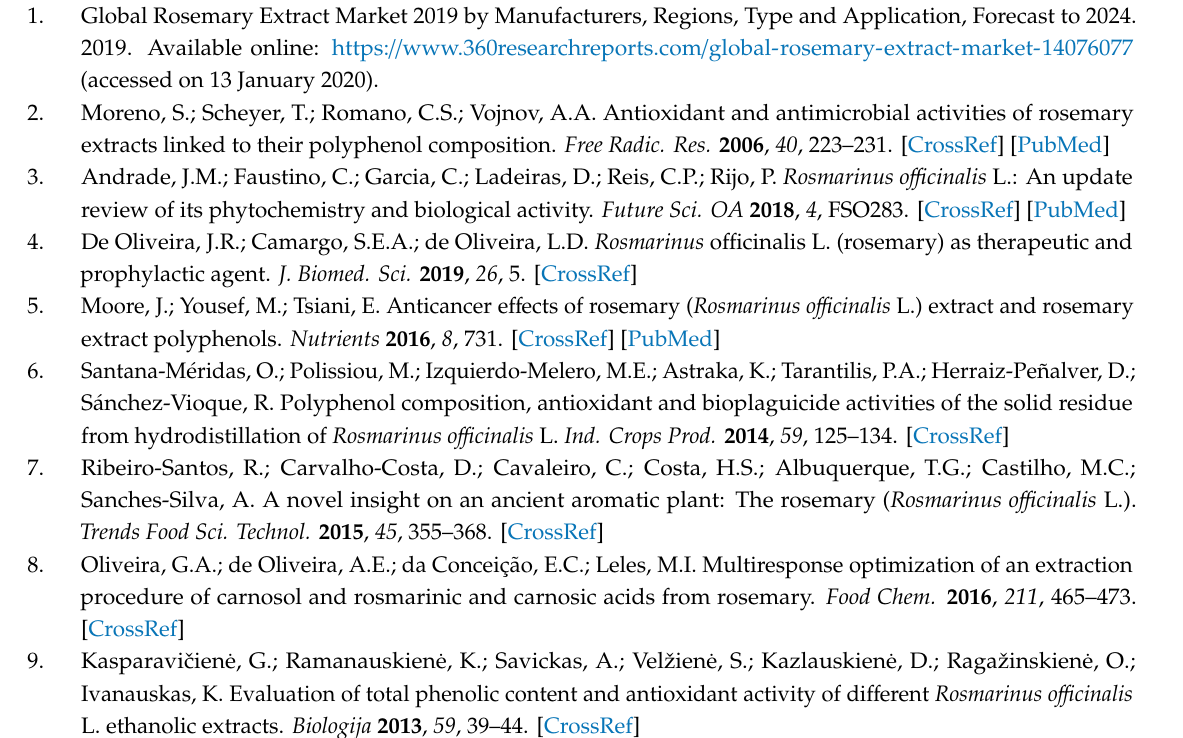
Supplementary Materials: The following are available online. Table S1: The e ff ect of the ethanol or acetone concentration (%) and of Ultrasound Assisted Extraction (UAE) on the initial concentration (C0) and the rate constant ( k ) of each extraction step of rosmarinic acid, total flavonoids and total phenolic diterpenes (sum of carnosic acid plus carnosol), as calculated by fitting Equation(1). The correlation coe ffi cients (R2) are also presented, Figure S1: The UV-Vis spectra of the minor peaks detected in the chromatograms of the water, acetone 100%, and water-acetone extracts, Figure S2: The recovery of the individual identified flavones with the increase of ethanol ( a ) and acetone ( b ) in extraction